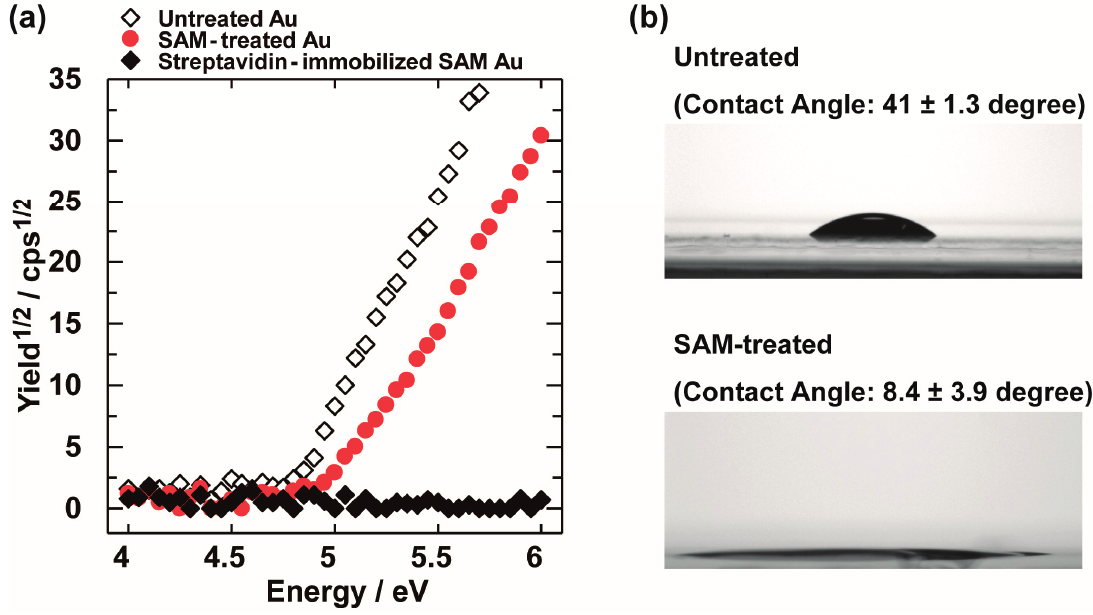
Figure 2. ( a ) Photoelectron yield spectroscopy measurements of the Au electrodes in air. Untreated Au (white diamond), 5-carboxy-1-pentanethiol-treated Au (red circle) and streptavidin-immobilized self-assembled monolayer (SAM) Au (black diamond); and ( b ) water contact angle measurements on the Au electrodes before and after SAM